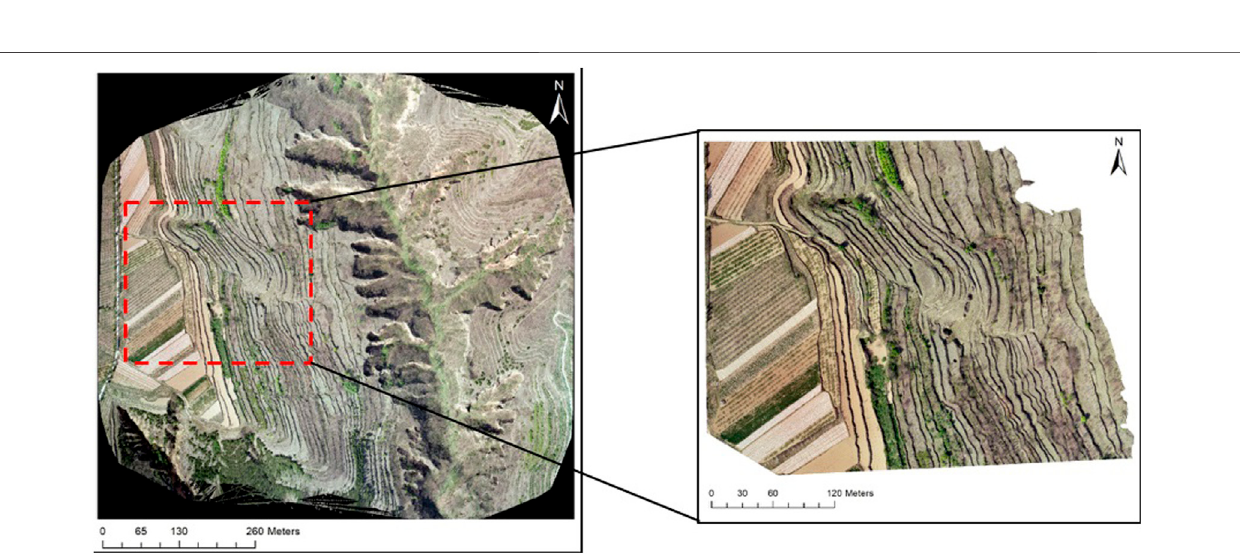
Frontiers in Environmental Science |